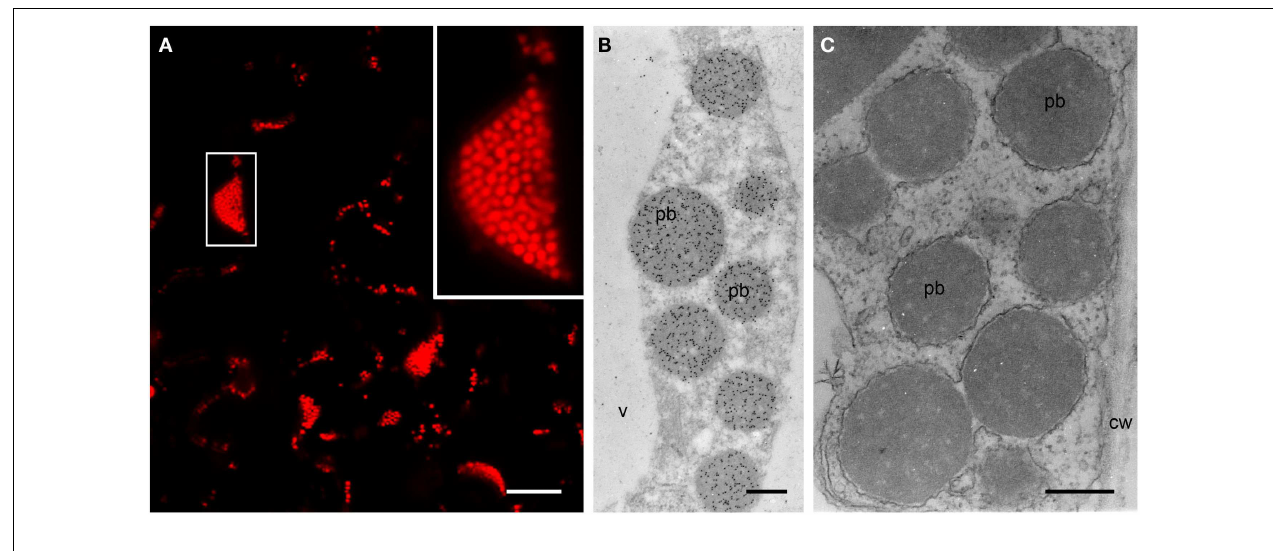
protein bodies (pb) showing abundant, specific labeling for DsRed (B) , surrounded by a ribosome-studded membrane [ (C) , arrowhead]. Cell wall (cw), vacuole (v). (C) Lipid staining. Bars = 25 µ m (A) or 0.5 µ m (B,C) .